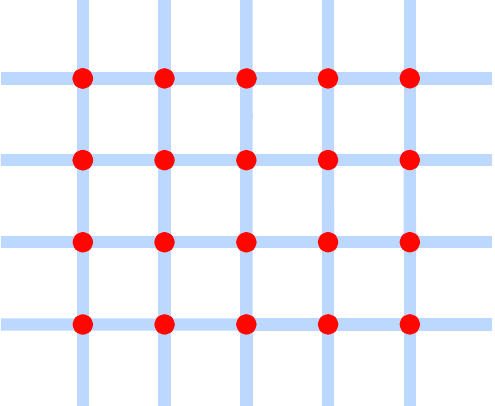
Figure 6. The network model of a porous